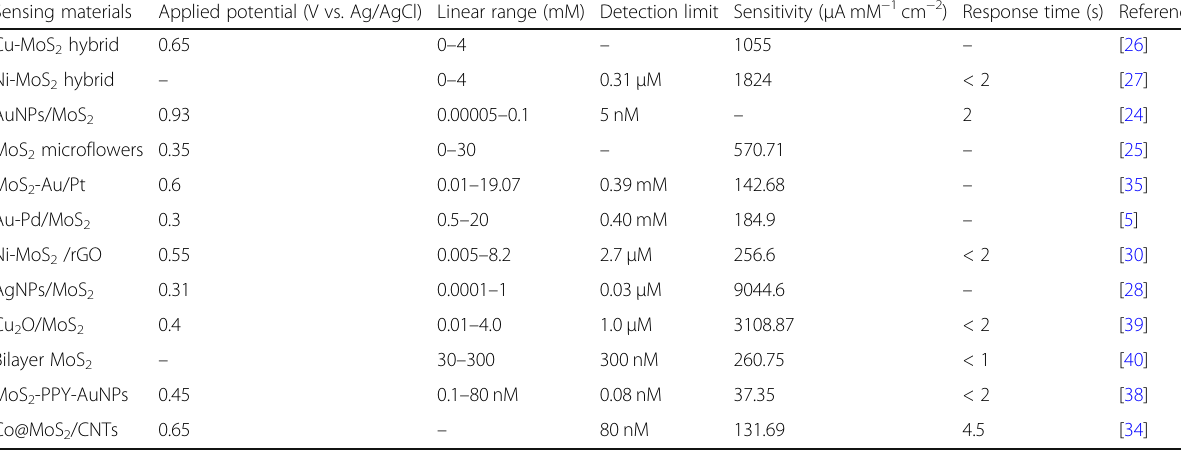
Table 1 Comparison of the enzyme-free glucose biosensors based on MoS 2 nanocomposites Sensing materials